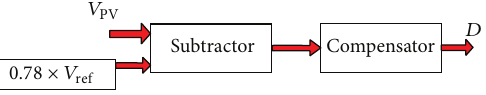
Figure 2: Flowchart of the CV